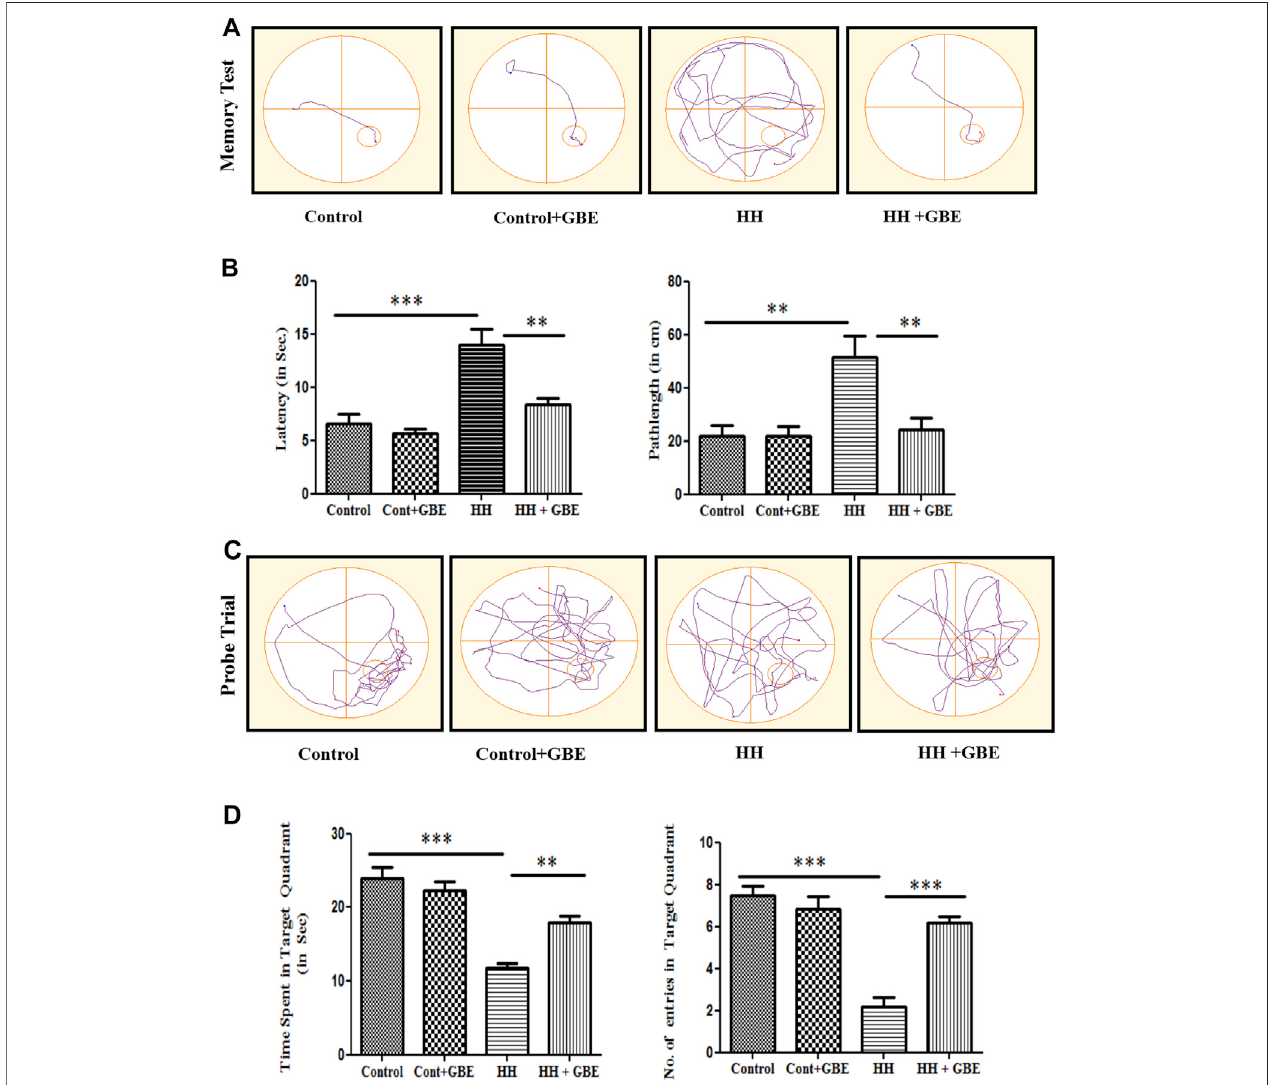
FIGURE 2 | GBE improves the spatial memory performance of rats in the MWM. The effect of GBE on memory was studied using the MWM spatial memory test. Representativetrackplotsofthememorytestandprobetrialofcontrol,control+GBE,HH,andHH+GBEgroups (A,C) .TreatmentofratswithGBEshowedprotective effect on HH-induced memory impairment as evident from the decreased latency and path length (B) and increased time spent and number of entries in the target quadrant (D) as compared to the HH group. One-way ANOVA with the Bonferroni test was used to analyze the data. Data are represented as mean ± SEM. “ ** ” represents p < 0.01, whereas “ *** ” represents p <